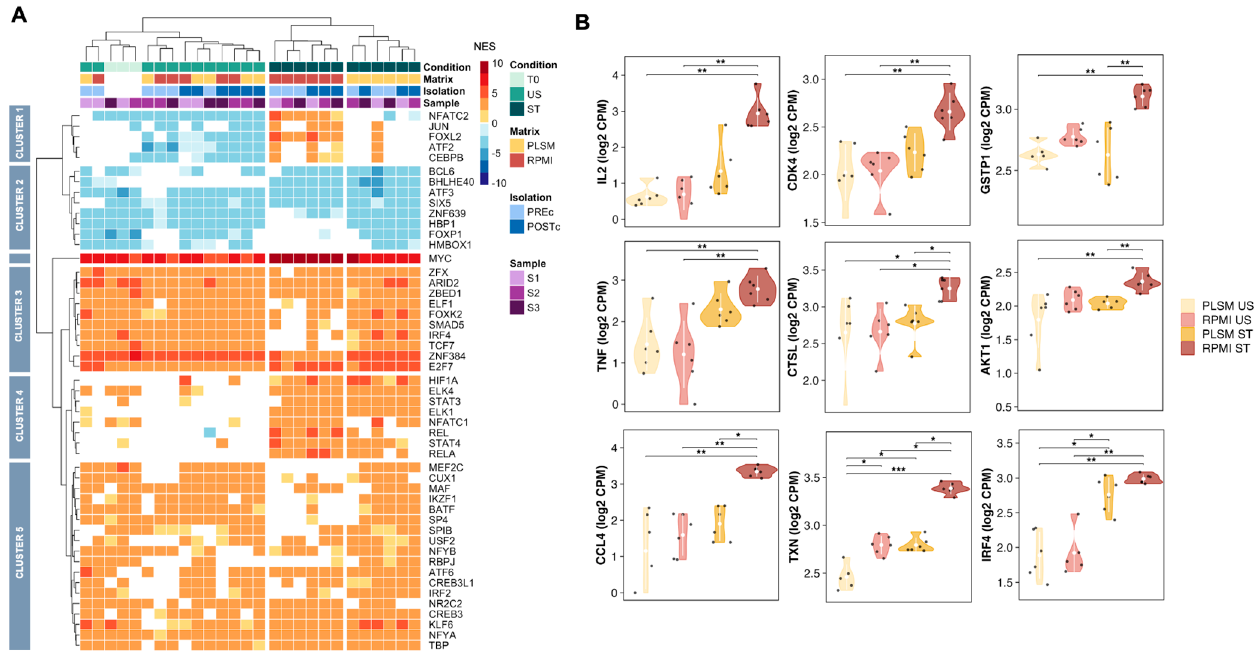
Figure 6. Inference of transcription factor activity and expression of their target genes. Heatmap of NES values from VIPER analysis on the transcription factor (TF) activity of single samples. Positive values (red) indicate active TFs, negative values (blue) show inactive TFs, while white indicates no significant results ( A ). Violin plots showing the expression difference after stimulation both in PLSM and in RPMI conditions of selected genes regulated by the NF-kB1, NFATC2, JUN, STAT5A, and STAT5B TFs. Statistical significance is indicated as follows: * for p-values less than 0.05, ** for p-values less than 0.01, and *** for p -values less than 0.001 ( B ).